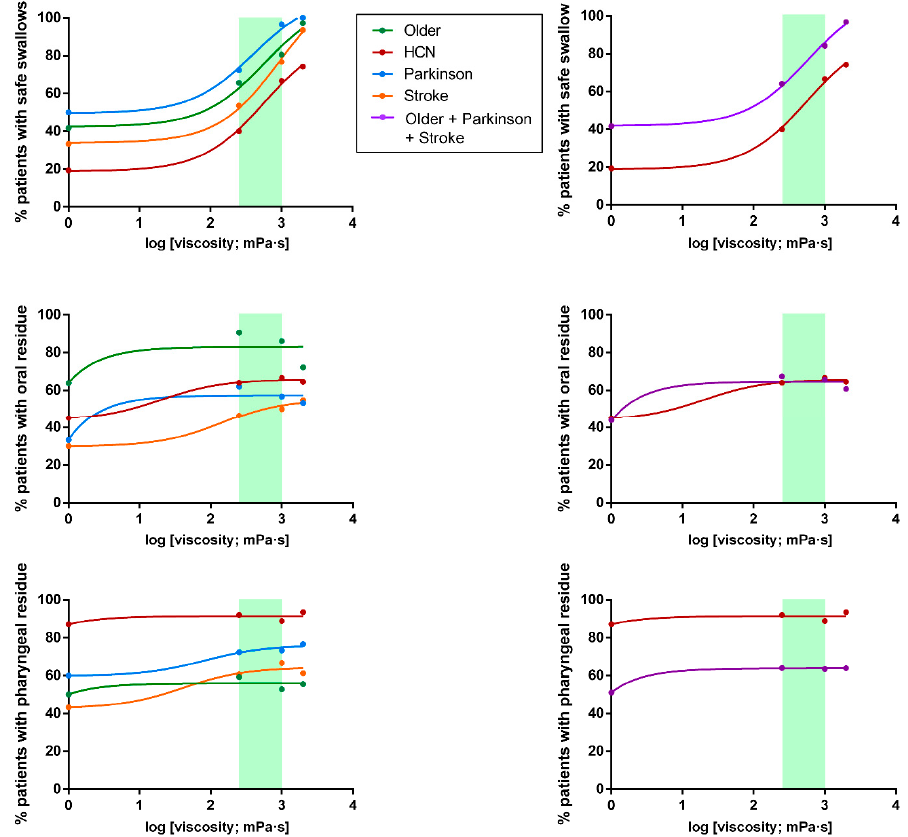
Figure 8. Viscosity-dependent e ff ect of FCT on the safety and e ffi cacy of swallow (oral and pharyngeal residue). Left: all groups of patients; right: older, Parkinson’s and stroke patients merged vs. patients with head and neck cancer. The therapeutic range has been marked with a green